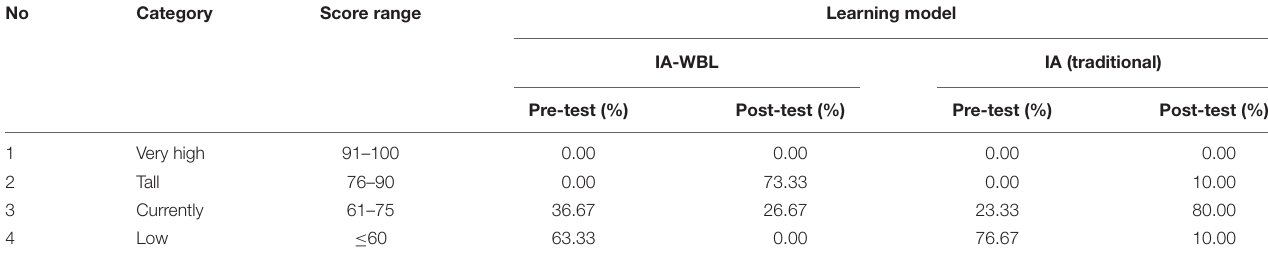
TABLE 4 | Results of pre-test and post-test attitudes on industrial apprenticeship.